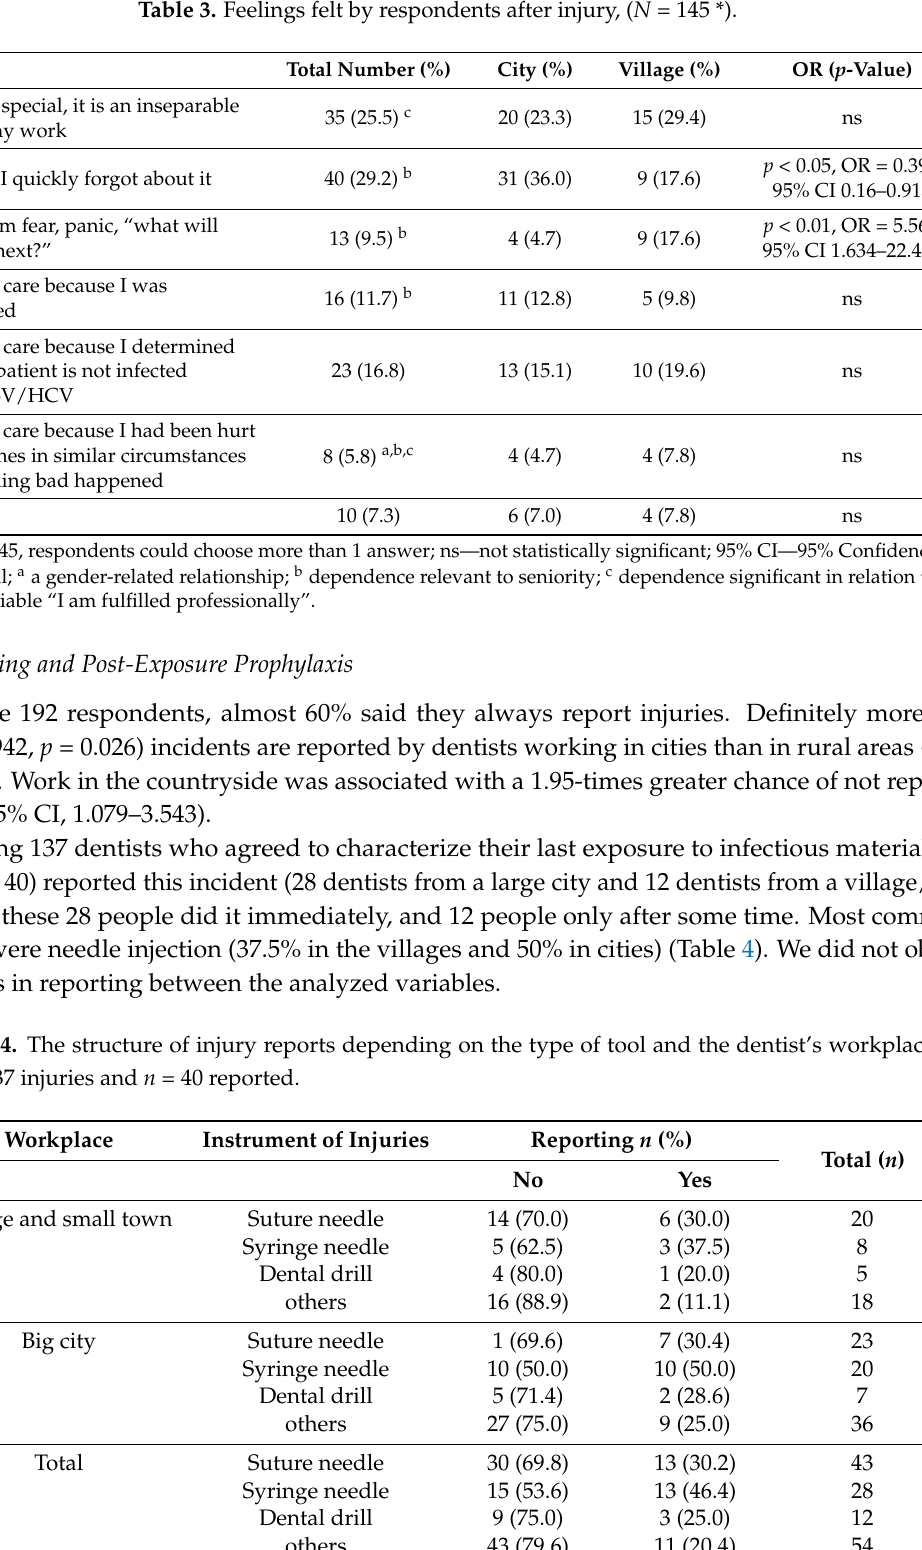
Table 3. Feelings felt by respondents after injury, ( N = 145 *).